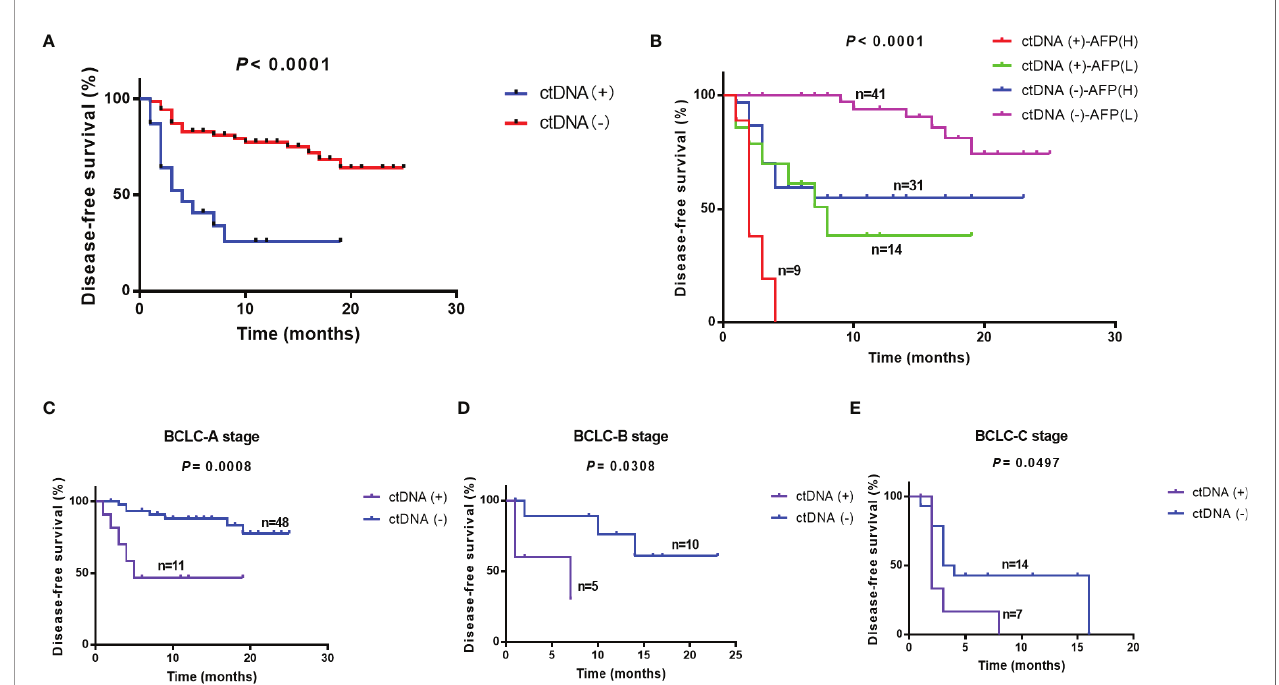
FIGURE 4 | Relationship between ctDNA positivity and other clinical factors and prognosis. (A) Disease-free survival in ctDNA (-) and ctDNA (+) groups. (B) Prediction of prognosis using ctDNA combined with AFP. Prediction of prognosis using ctDNA in patients with different BCLC stages: (C) BCLC-A stage, (D) BCLC-B stage, (E) BCLC-C stage. AFP, alpha-fetoprotein; BCLC, Barcelona Clinic Liver Cancer.